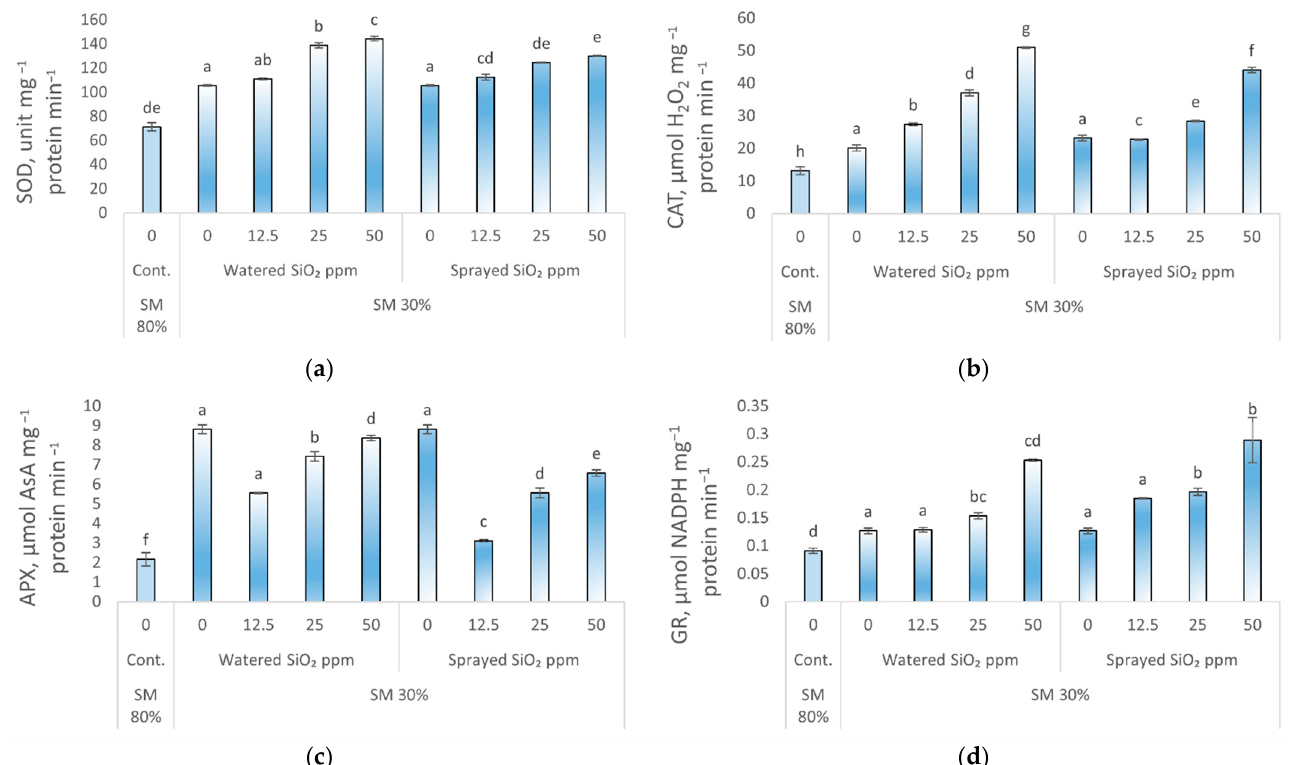
Figure 4. Response of ( a ), superoxide dismutase (SOD); ( b ), catalase (CAT); ( c ), ascorbate peroxidase (APX); ( d ), glutathione reductase (GR) activity to drought stress and SiO 2 NPs (0; 12.5; 25; and 50 ppm) in P. sativum L. Cont.—control plants, substrate moisture (SM) 80%; drought stress—SM 30%. Values are mean ± SE of three replicates and different letters are differed significantly by Tukey HSD Test ( p <